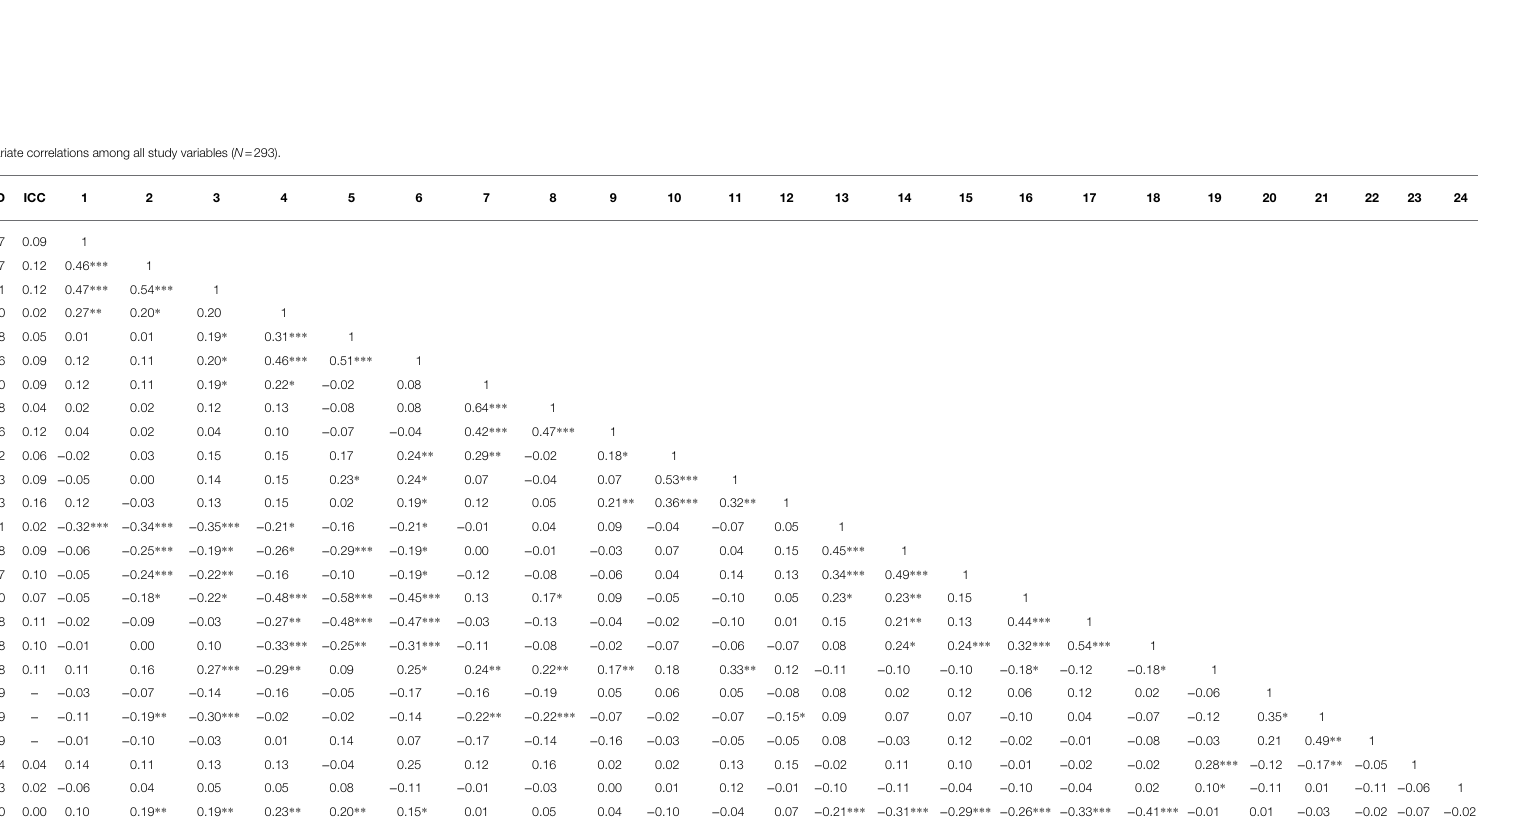
TABLE 1 | Zero-order bivariate correlations among all study variables ( N = 293).